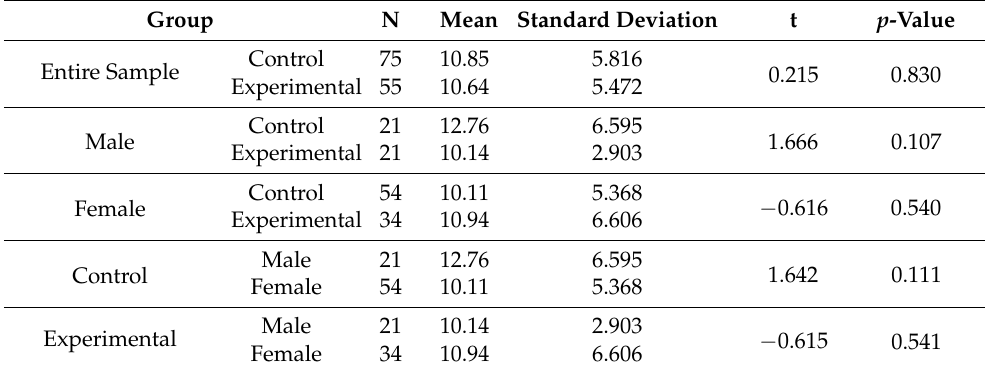
Table 1. Independent Sample t-test Results for the Differences between Groups and Genders in the Pretest.